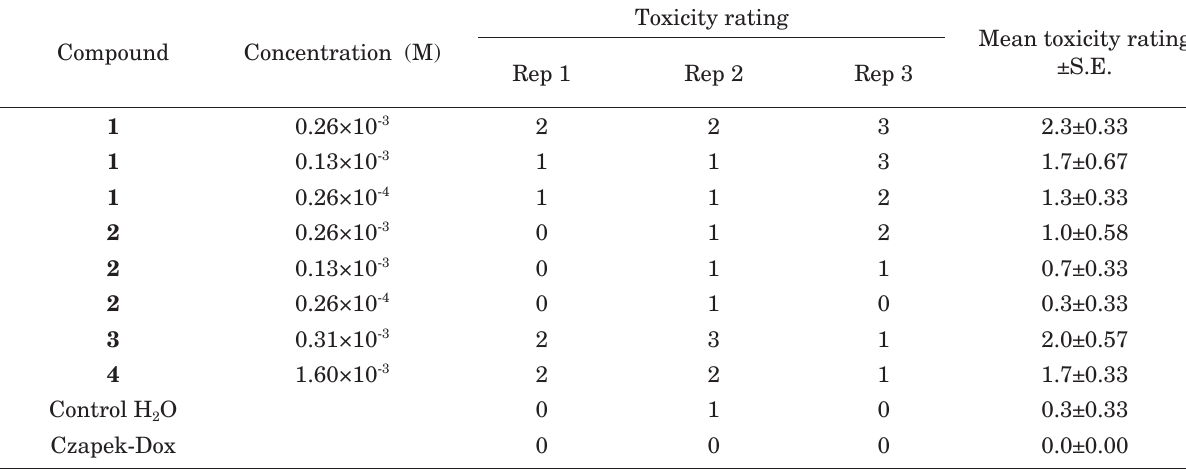
Table 1. Phytotoxicity of (3 R ,4 R )-(-) -4-hydroxymellein, (3 R ,4 S )-(-) -4-hydroxymellein, isosclerone and tyrosol ( 1 - 4 ) on tomato plants a